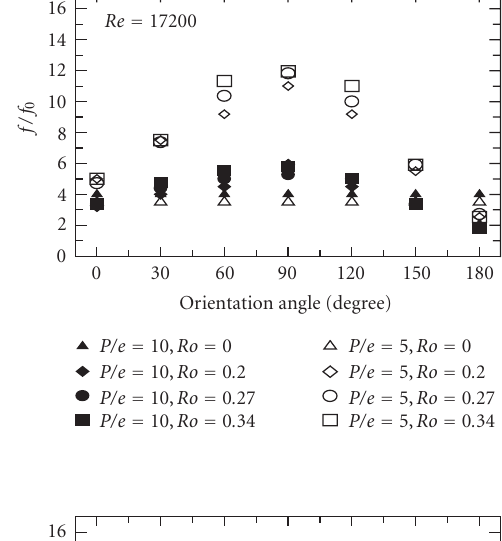
Figure 6: Comparison of friction factor ratios in square channels with detached (D) and attached (A) rib configurations (for de- tached ribs, Re = 17000 and for attached ribs, Re =